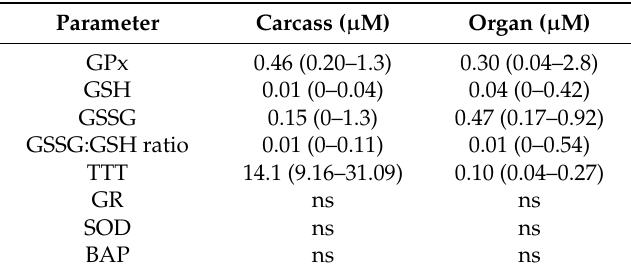
Table 2. Effects of embryonic CdCl 2 exposure on baseline values of antioxidative parameters.